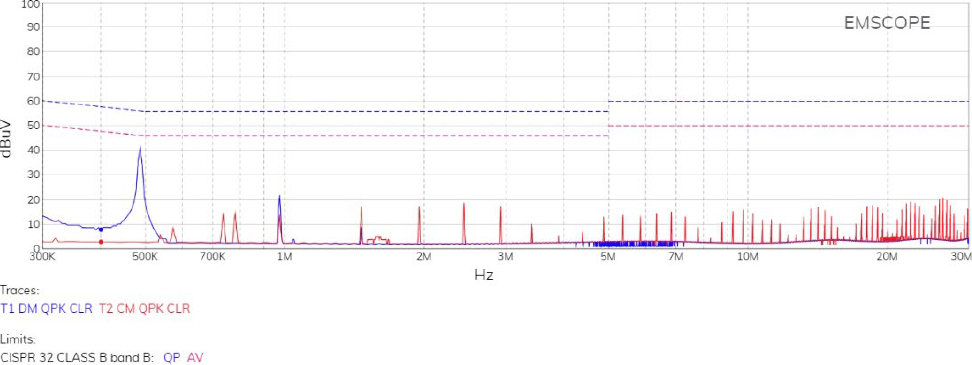
Figure 20. CM (red) and DM (blue) were obtained with a filter composed of a Cx = 0.47 uF and an L = 0.99 uH. Amplitude units are in dBµV, and Frequency units are in Hz.